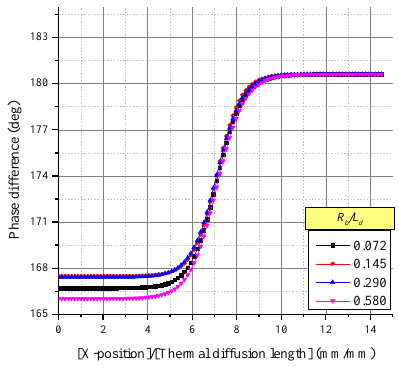
Figure 13. ERF according to changes in 𝑅 𝑏 /𝐿 𝑑 .